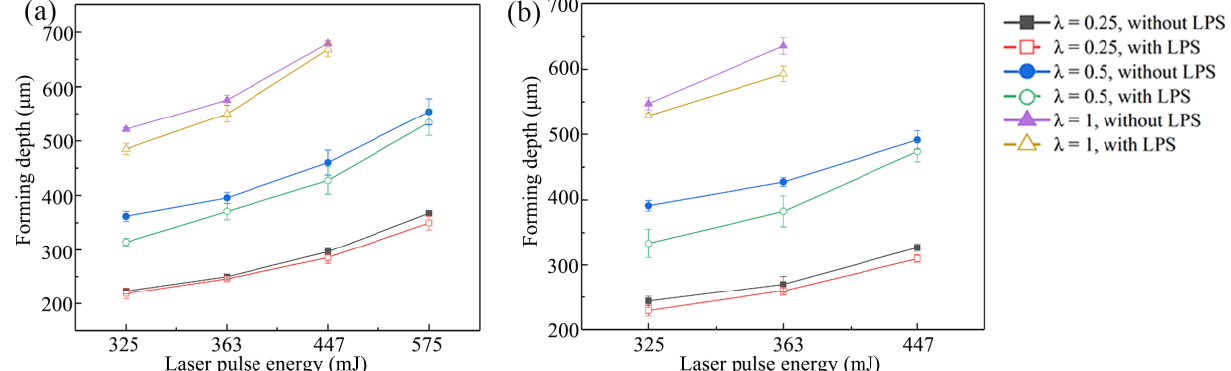
Figure 6. Effect of mold characteristic size on the forming depth of bulging samples. ( a ) Annealed at 450 ◦ C; ( b ) annealed at 650 ◦ C.